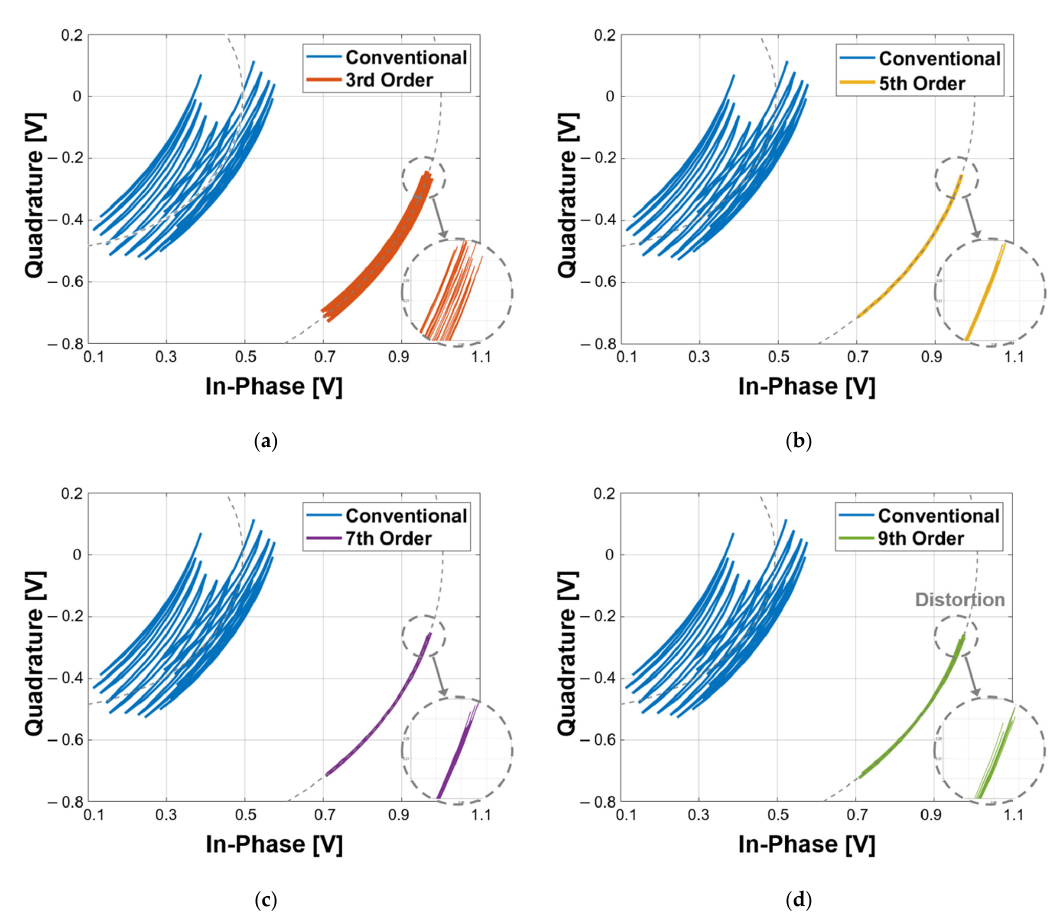
Figure 6. Simulation results using the conventional method for cancelling static DC offset and the proposed detrending technique using: ( a ) 3rd-order polynomials; ( b ) 5th-order polynomials; ( c ) 7th-order polynomials; ( d ) 9th-order polynomials.